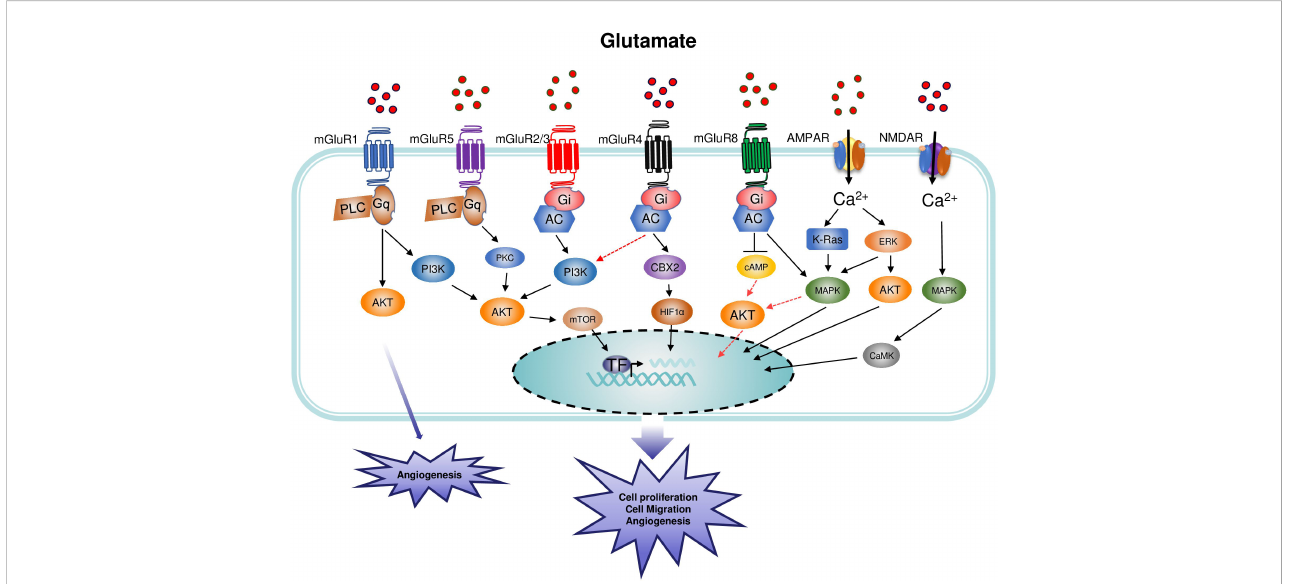
FIGURE 3 Main signaling pathways involved in the regulation of cancer by metabotropic glutamate receptor (mGluR) and inotropic glutamate receptor (iGluR). Group I mGluRs are coupled to phospholipase C (PLC) while groups II and III are coupled to adenylate cyclase (AC). NMDAR are ligand-gated ion channels that mediate a rapid depolarization of the membrane. The binding of glutamate to the glutamate binding site acts as a fi rst messenger and induces the depolarization of the membrane leading to the in fl ux of Ca 2+ in the intracellular space, followed by the activation of the corresponding signaling pathways. Glutamate is the agonist of AMPAR, and the channel opens when two sites are occupied by glutamate. Within the receptor, the GluN2 subunit plays a critical role in the determination of the Ca 2+ permeability of the AMPAR. Upon binding of the amino-acid glutamate to its receptors, the intracellular signal transduction mechanisms induce the activation of different signaling pathways leading to cell proliferation and tumor